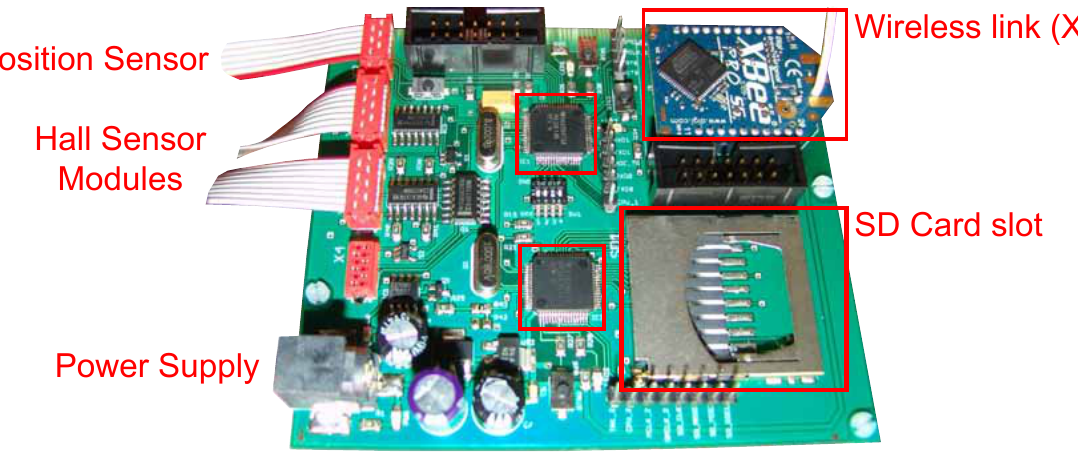
Figure 3. DAQ PCB